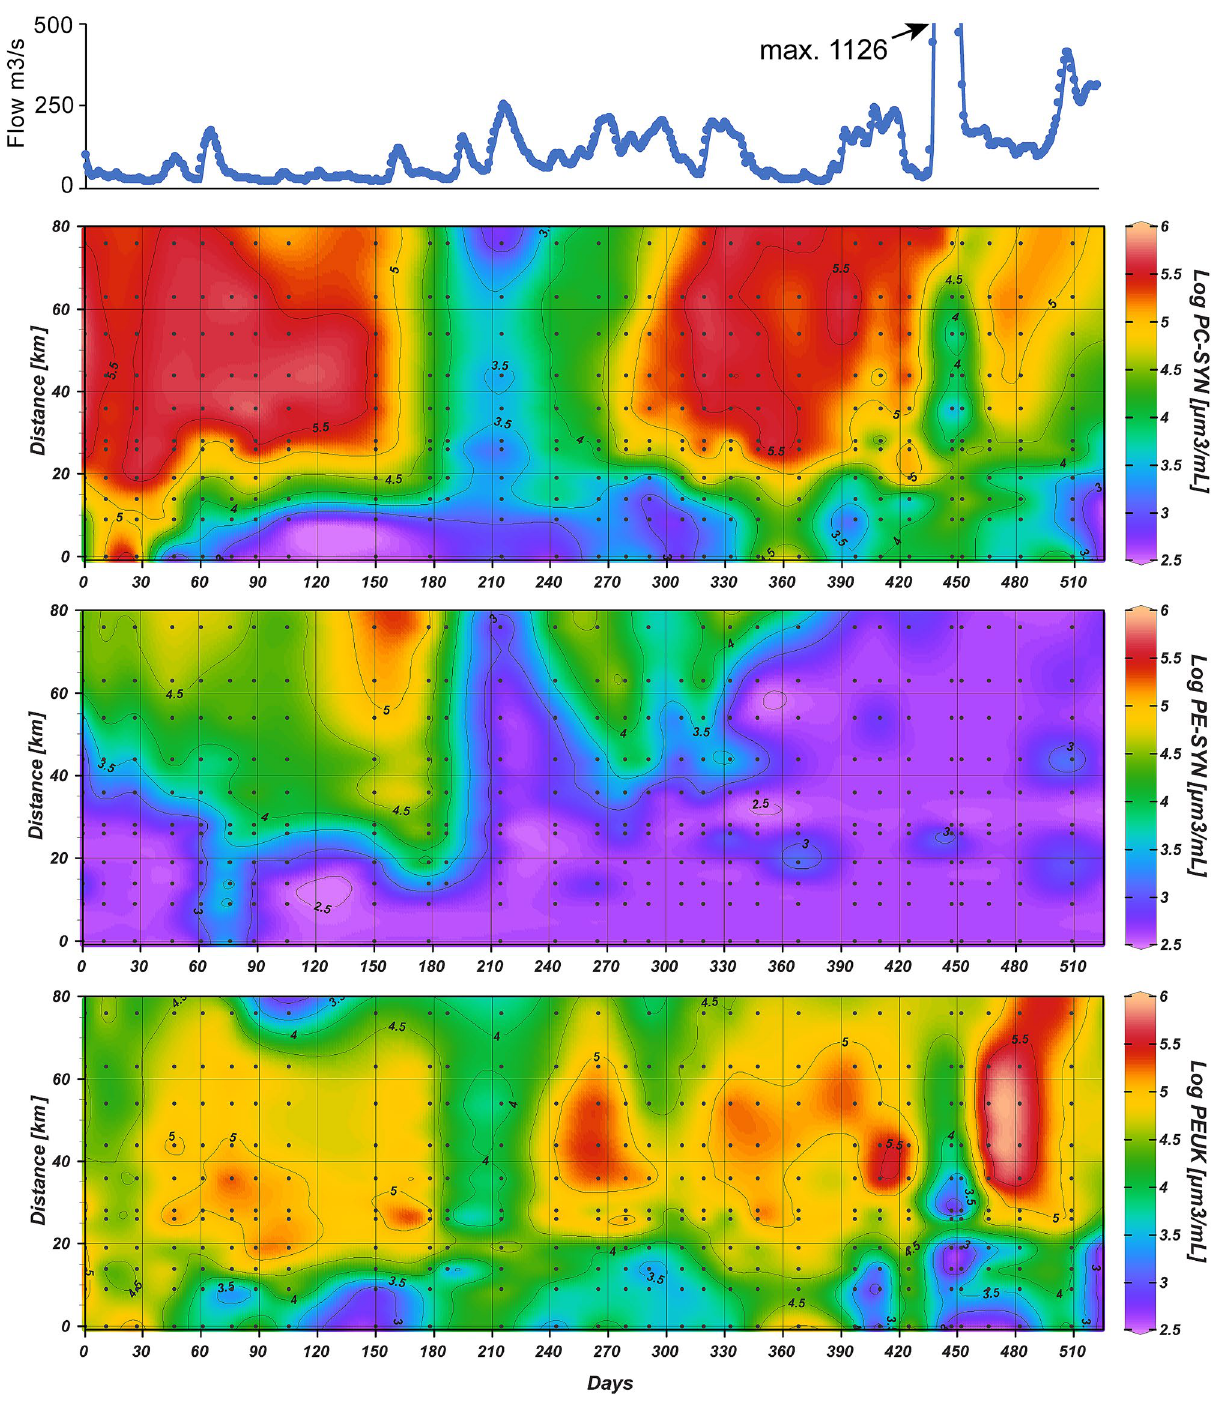
Figure 4. Biovolume concentrations for each NRE PicoP morphotype across NRE samplings. FCM-derived cell abundance (Fig. 3) and cell diameter (Supplementary Fig. S7) data were used to obtain biovolume per water volume. Neuse River flow rate is shown in the top panel for